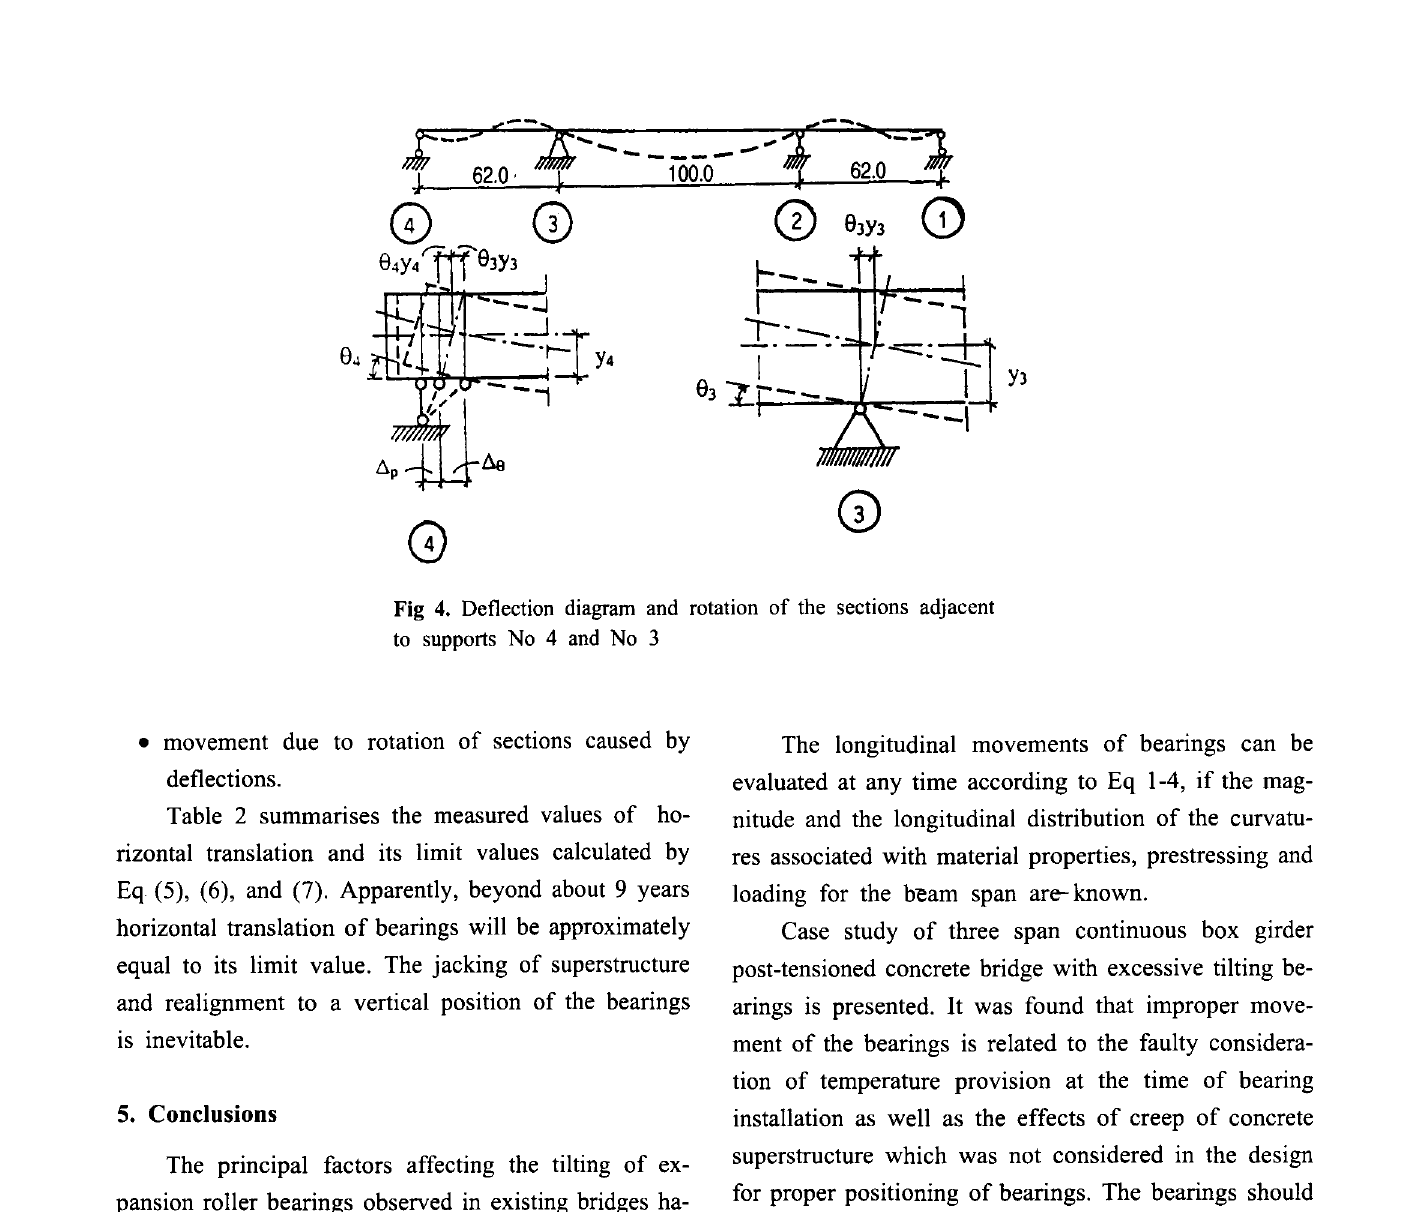
Table 2. Horizontal translation of bearings No 4 Horizontal translation Rate of